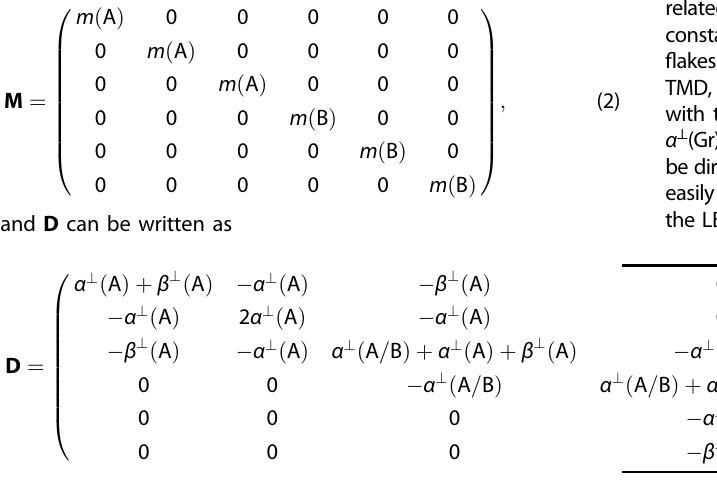
weak electron-phonon coupling, so that α ⊥ (hBN), α ⊥ (Gr), and β ⊥ (Gr)